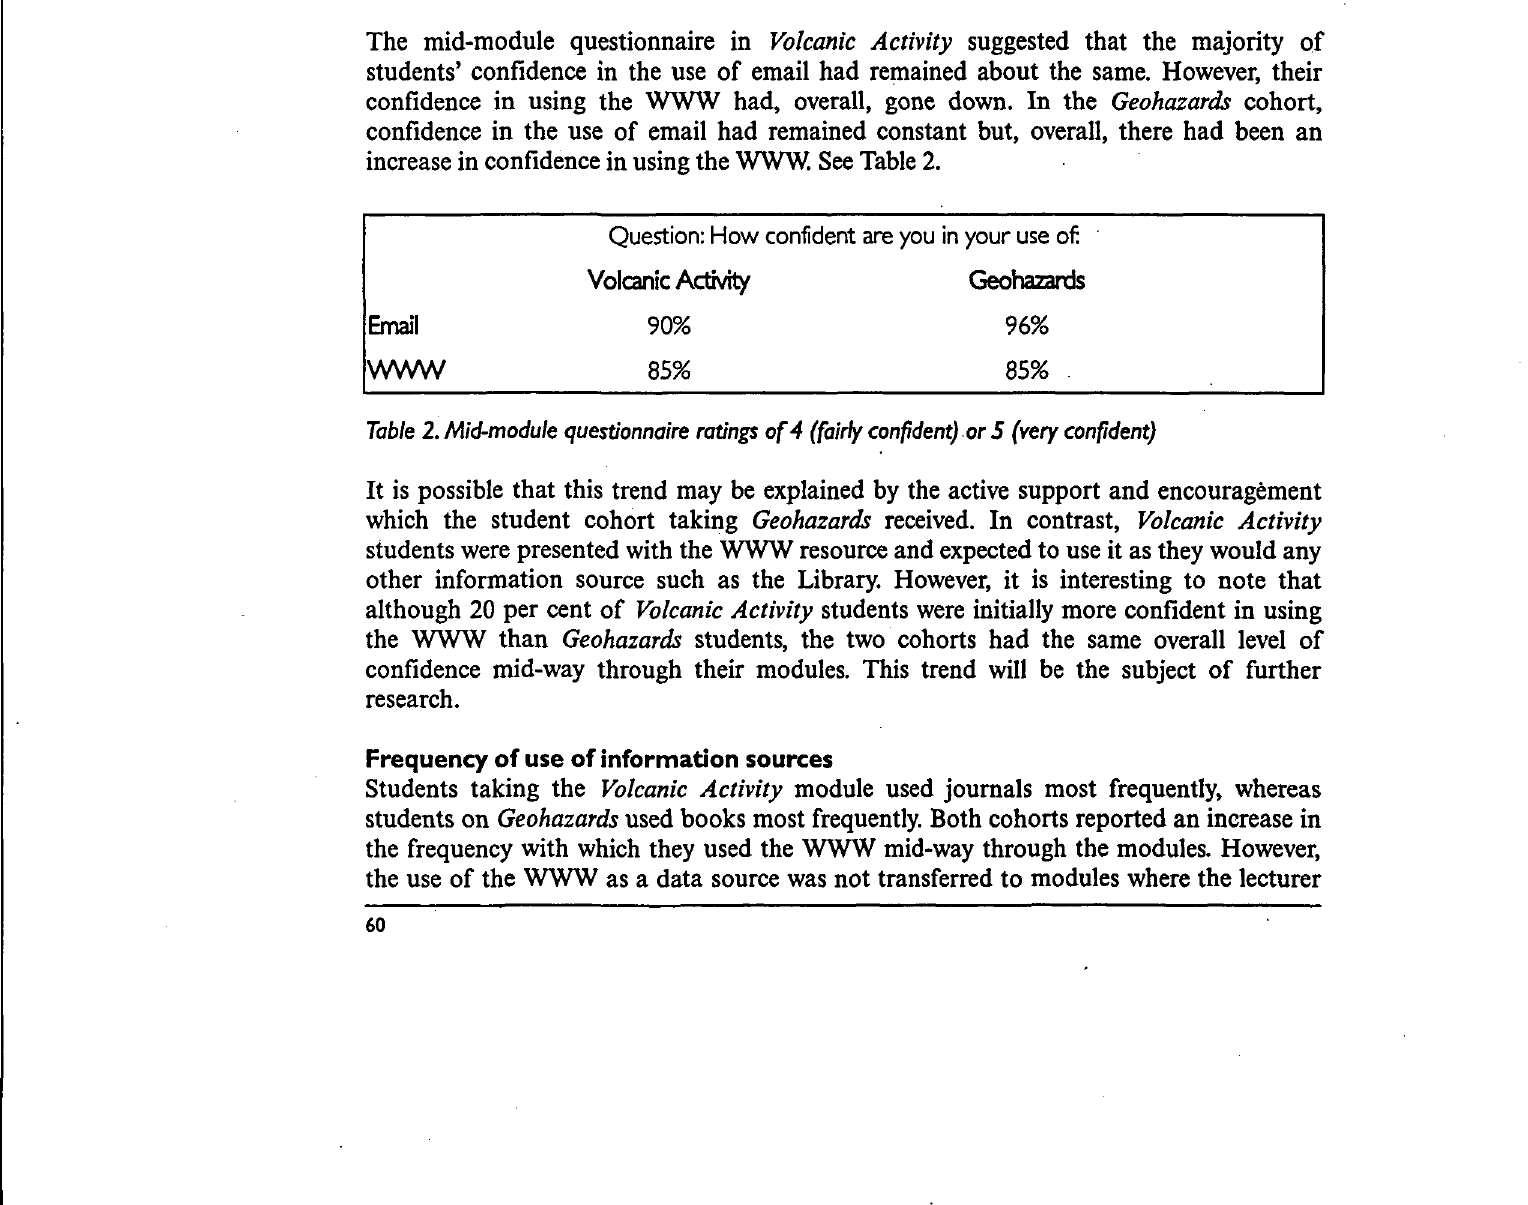
Table I. Pre-module questionnaire ratings of 4 (fairly confident) or 5 (very confident)